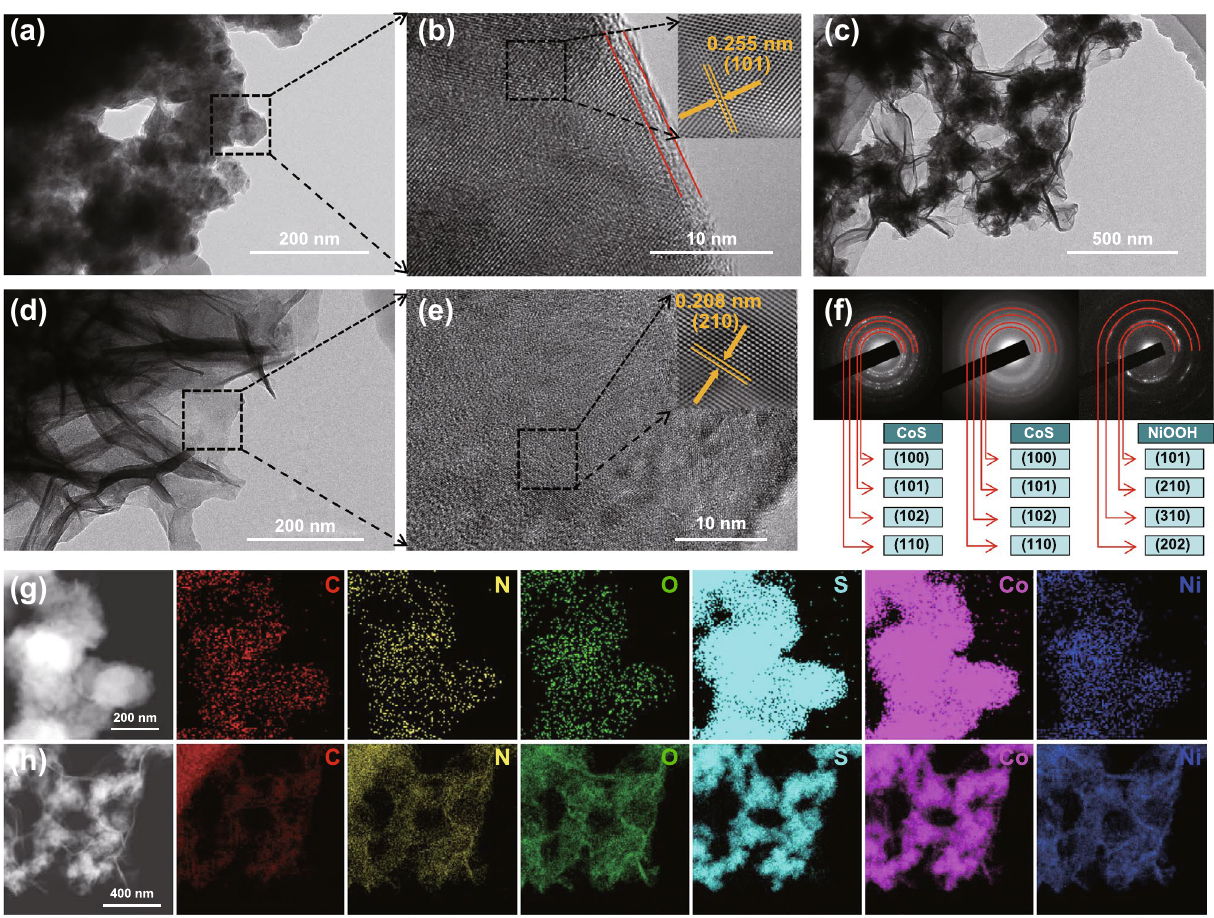
Fig. 2 a TEM of NF-C/CoS. b HRTEM of NF-C/CoS (inset: FFT inverse pattern). c–d SEM of NF-C/CoS/NiOOH. e HRTEM of NF-C/CoS/ NiOOH (inset: FFT inverse pattern). f SAED patterns of Fig. 2 a , c, and d , respectively. g HADDF image and elemental mapping of NF-C/CoS. h HADDF image and elemental mapping of